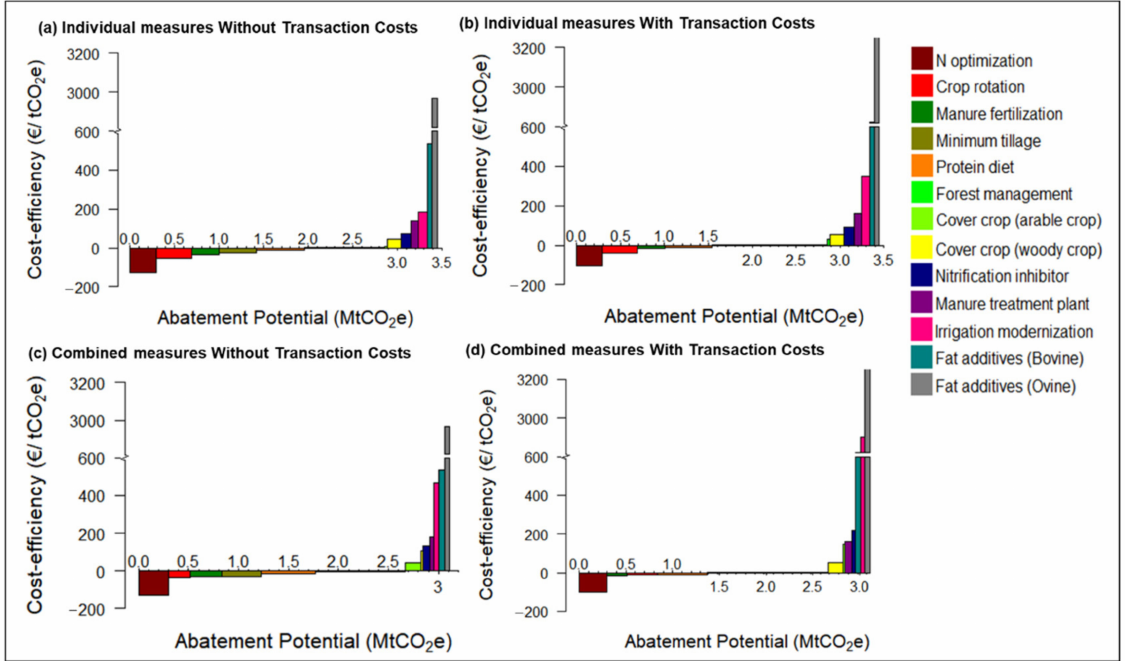
Figure 4. Marginal Abatement Cost Curve (MACC) of individual and combined